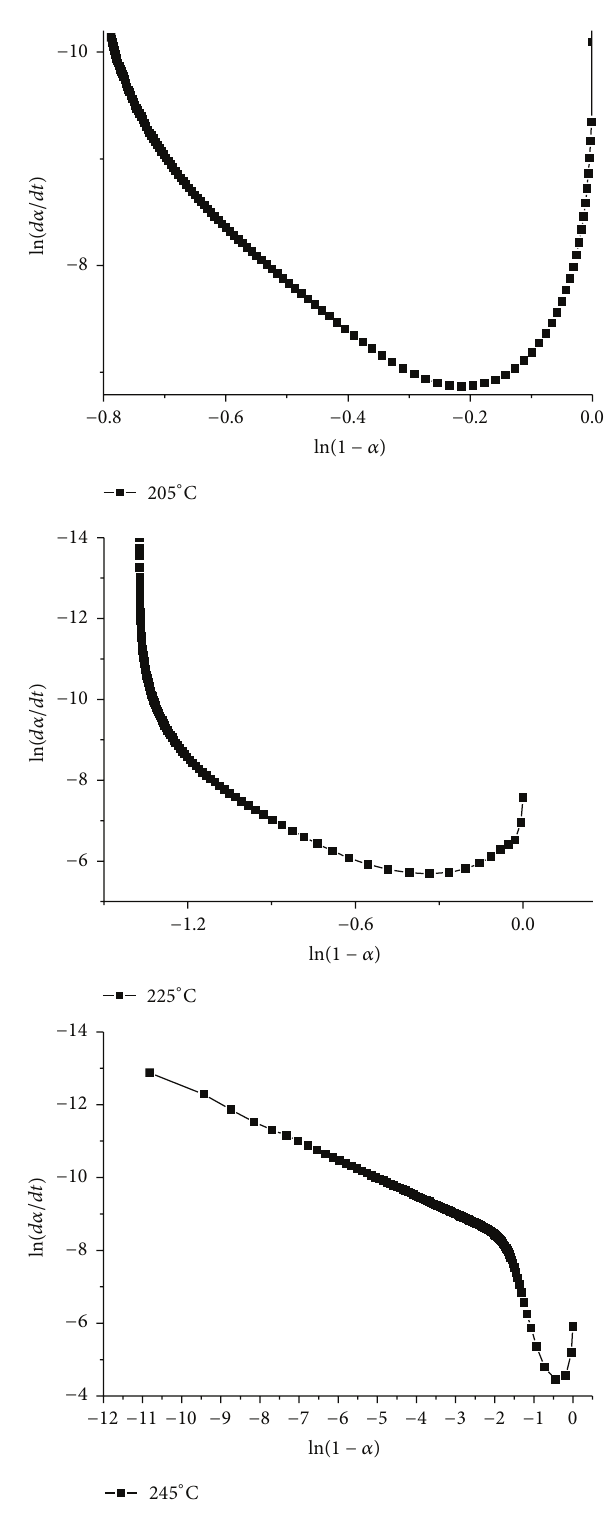
Figure 8: ln (𝑑𝛼/𝑑𝑡) versus ln (1 − 𝛼) curves of BZ homopolymers. BZ monomer and the F-51/BZ mixture system in